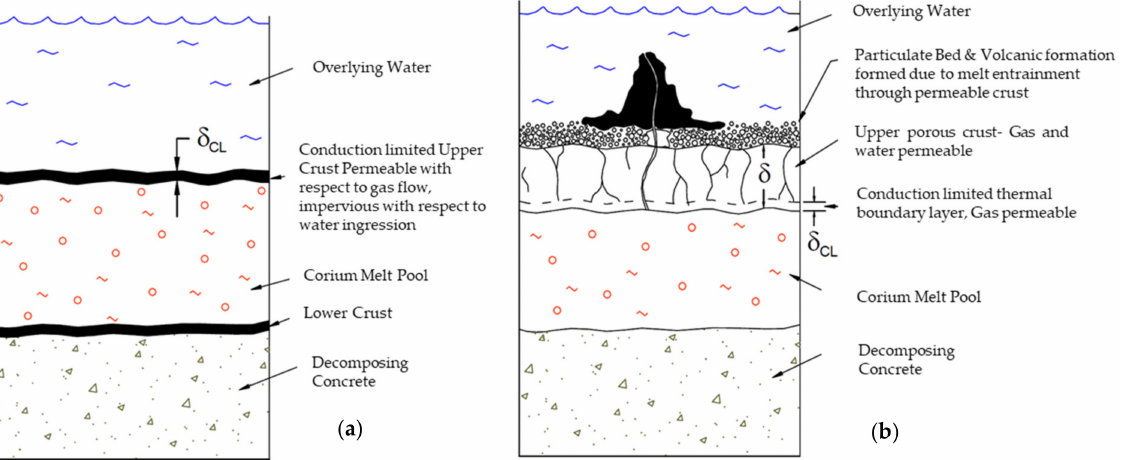
Figure 1. Schematic of molten corium–concrete interaction: ( a ) view with conduction-limited upper crust at the molten corium–water interface; ( b ) view with water ingression and molten corium eruption cooling mechanisms